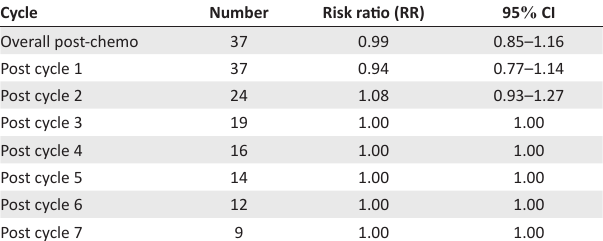
TABLE 7: Chemotherapy-induced alopecia risk ratio: curly versus straight hair. Cycle Number Risk ratio (RR) 95 % CI Overall post-chemo